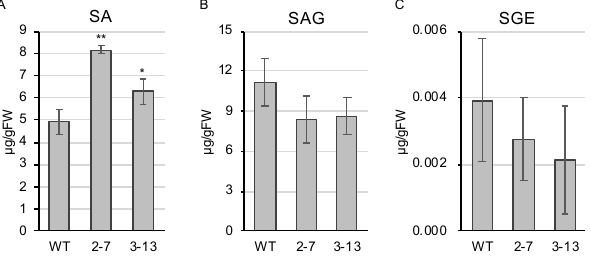
Figure 4. ugt74j1 mutants overaccumulate SA under non-stressed conditions. ( A – C ) Salicylic acid (SA), SA 2- O - β -glucoside (SAG), and salicyloyl-glucose ester (SGE) were extracted from the fifth leaf of 25-d-old plants and quantified using UPLC-MS/MS. The data represent the means of four inde- pendent experiments ± SE. Significant differences were calculated using Student’s t -tests: * p < 0.05; ** p <